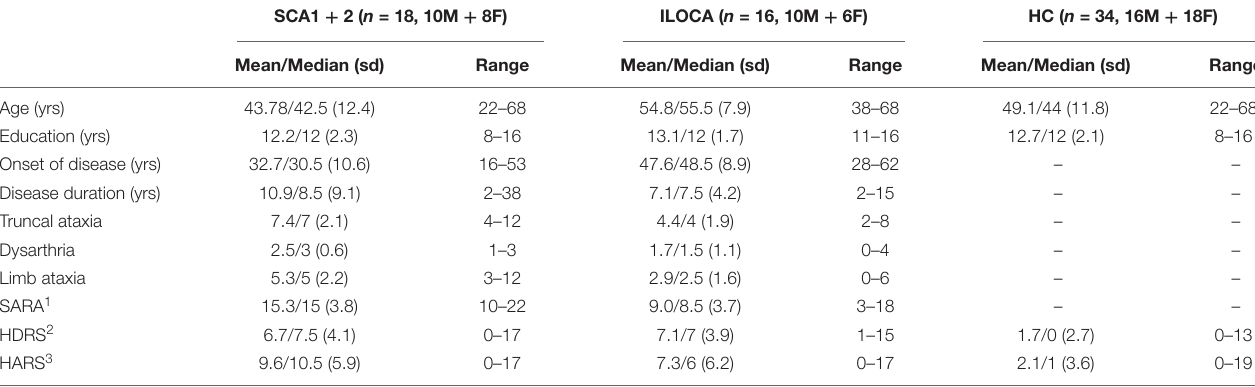
TABLE 1 | Socio-demographic characteristics of groups, clinical characteristics and mood scales – descriptive